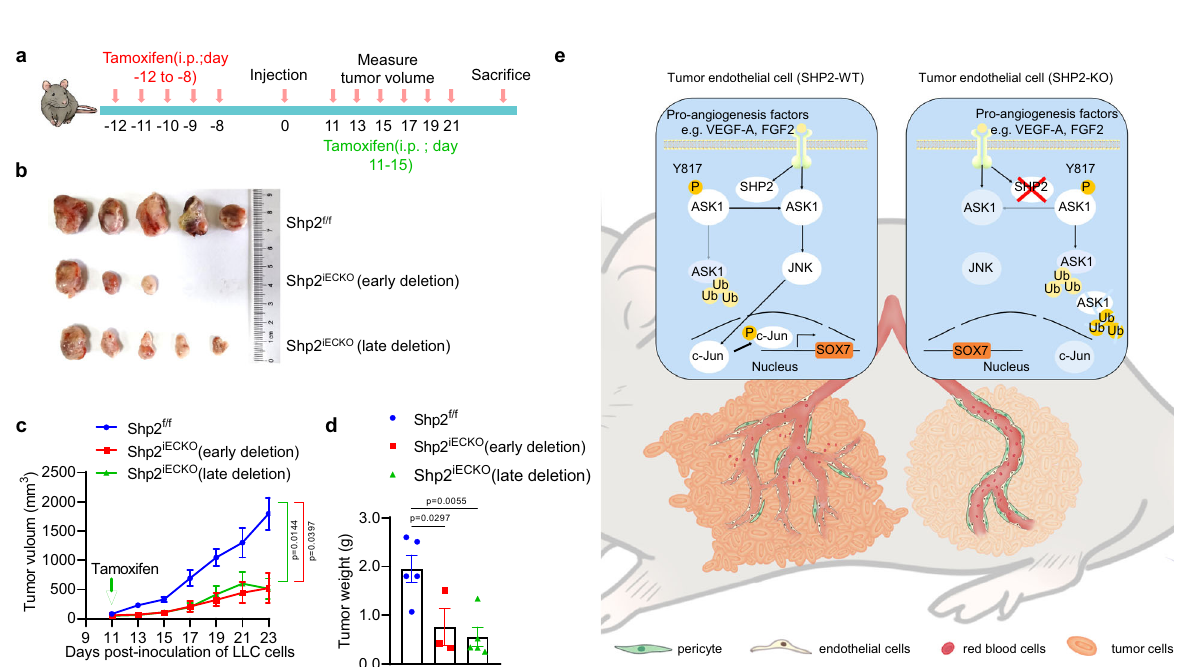
Fig. 8 Targeting endothelial SHP2 inhibits tumor growth. a Schematic representation of the experimental model to delete Shp2 after tumor growth (late deletion). For late Shp2 deletion, tumors were grown in Shp2 f/f and Shp2 iECKO mice before tamoxifen was administered when the tumors reached a diameter of 5 mm. b Images of explant LLC tumors from Shp2 f/f and Shp2 iECKO mice (early deletion or late deletion). Scale bar: 10 mm. c , d The volumes ( c ) and weights ( d ) of LLC tumors from Shp2 f/f ( n = 5) and Shp2 iECKO (early deletion, n = 3; late deletion, n = 5) mice. The weights were recorded 11 days after cancer cell injection. Quantitative data were shown as mean ± SEM. p -values were shown and generated by two-way ANOVA with Tukey ’ s post hoc test ( c ) or by using the two-tailed Student ’ s t -test ( d ). e Schematic illustration showing the role and mechanism of SHP2 in regulating tumor angiogenesis and vessel abnormality. In tumor-associated endothelial cells, expression of protein tyrosine phosphatase SHP2 is upregulated in response to signals from cancer cells. SHP2 dephosphorylates and stabilizes ASK1, which promotes c-Jun signaling to induce SOX7 expression. SOX7 is a proangiogenic factor and promotes tumor angiogenesis to produce tumor vessels with inef fi ciency in pericyte coverage, barrier integrity, and vessel perfusion. When SHP2 is genetically deleted or pharmacologically inhibited, through ASK1-c-Jun signaling, SOX7 expression is reduced. Reduced SOX7 expression results in a decrease in tumor angiogenesis while produces tumor vessels with well pericyte coverage, barrier integrity, and vessel perfusion. SHP2-ASK1-c-Jun-SOX7 is an important signaling axis in regulation tumor angiogenesis and vessel normalization, thus rendering the signaling pathway, especially SHP2, whose allosteric inhibitor is available, a valuable target for the development of anti-angiogenic therapy in cancers. Source data are provided as a Source data fi